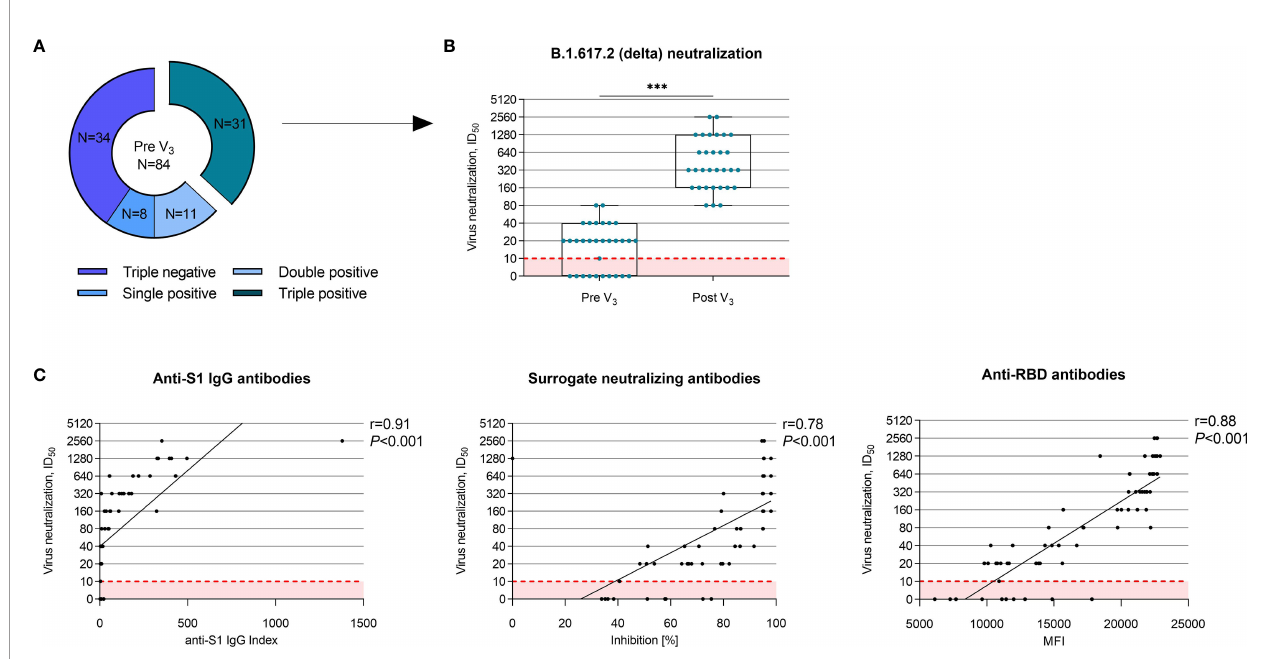
FIGURE 3 | Vaccine-inducedcross-neutralizationagainsttheB.1.617.2 (delta)variantofconcerninseroconvertedhemodialysispatients. (A) Prior toathirdvaccinedose, 31/84 (37%)hemodialysispatientsshowedaseroconversioninallthreecommerciallyavailableassays,namelyanti-S1IgG ≥ 1, surrogateneutralizingantibodies withaninhibition ≥ 30% andanti-RBDantibodies withanMFI ≥ 5800.Inthese31individuals, neutralizationagainsttheB.1.617.2 (delta)variantwasperformedusingalivevirusassay. (B) Neutralization againsttheB.1.617.2(delta) variantbefore andaftera thirdvaccinedosein31hemodialysispatients. TheID 50 indicatesthe serum dilutionthatinhibits50% oftheinfectivity. A neutralizationtiter of1:10is thecut-offfor thistest, indicatedbya dashedredline. (C) Correlationofcommerciallyavailabletestssuchas anti-S1IgG, surrogateneutralizingand anti-RBDanti-wild-type antibodiestovaccine-inducedcross-neutralizationagainsttheB.1.617.2(delta) variant.Spearman ’ srhoasanonparametricmeasureofrankcorrelation wascalculatedforallassays. ID 50 ; inhibitorydilution50; MFI,mean fl uorescenceintensity;N, number;V,vaccination; *** P